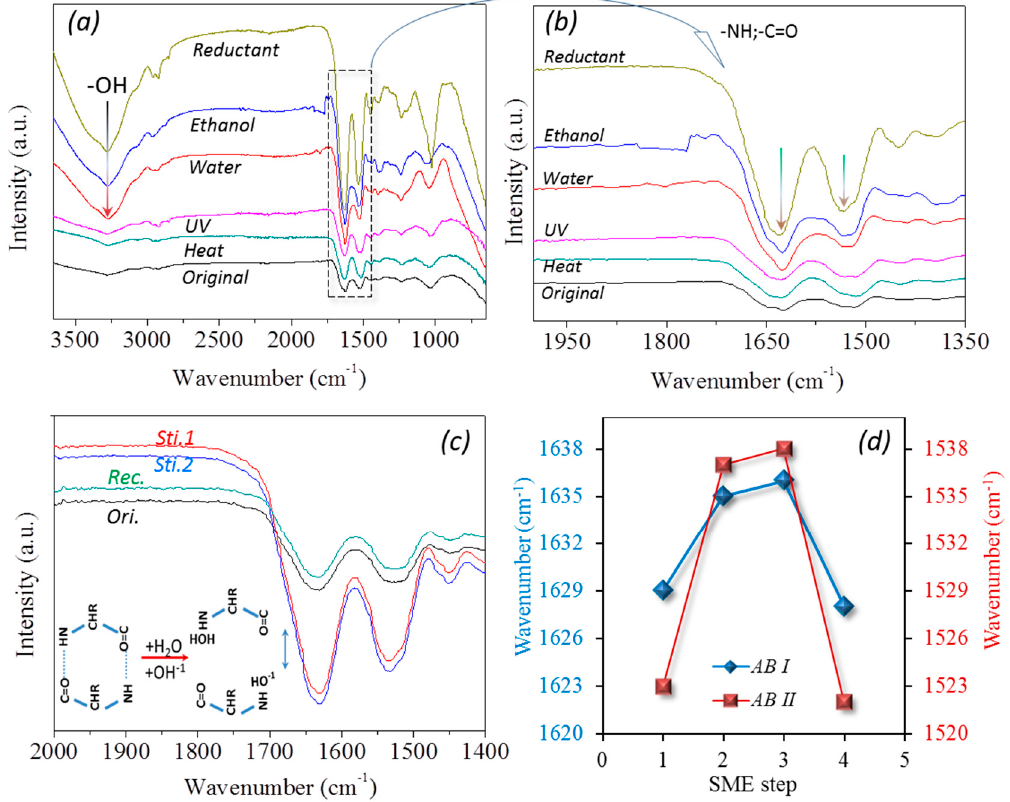
Figure 9. FTIR characteristic peaks of goat hair fibers under original status and processed states under heat, UV light, water, ethanol, and reductant solutions, where ( a ) shows the whole spectra and the dashed frame is presented in the enlarged figure; ( b ) for the specific functional groups –NH and –C=O representing HBs switched on and off, using wavenumber shifting and ratio variation of peak intensity that also means disruption and re-formation of HBs from IR peak shifting; ( c ) a case of goat hair under a group of coupled ethanol-water responsive key SME steps that ( d ) shows the wavenumber shifting of the two characteristic peaks at the four key steps.